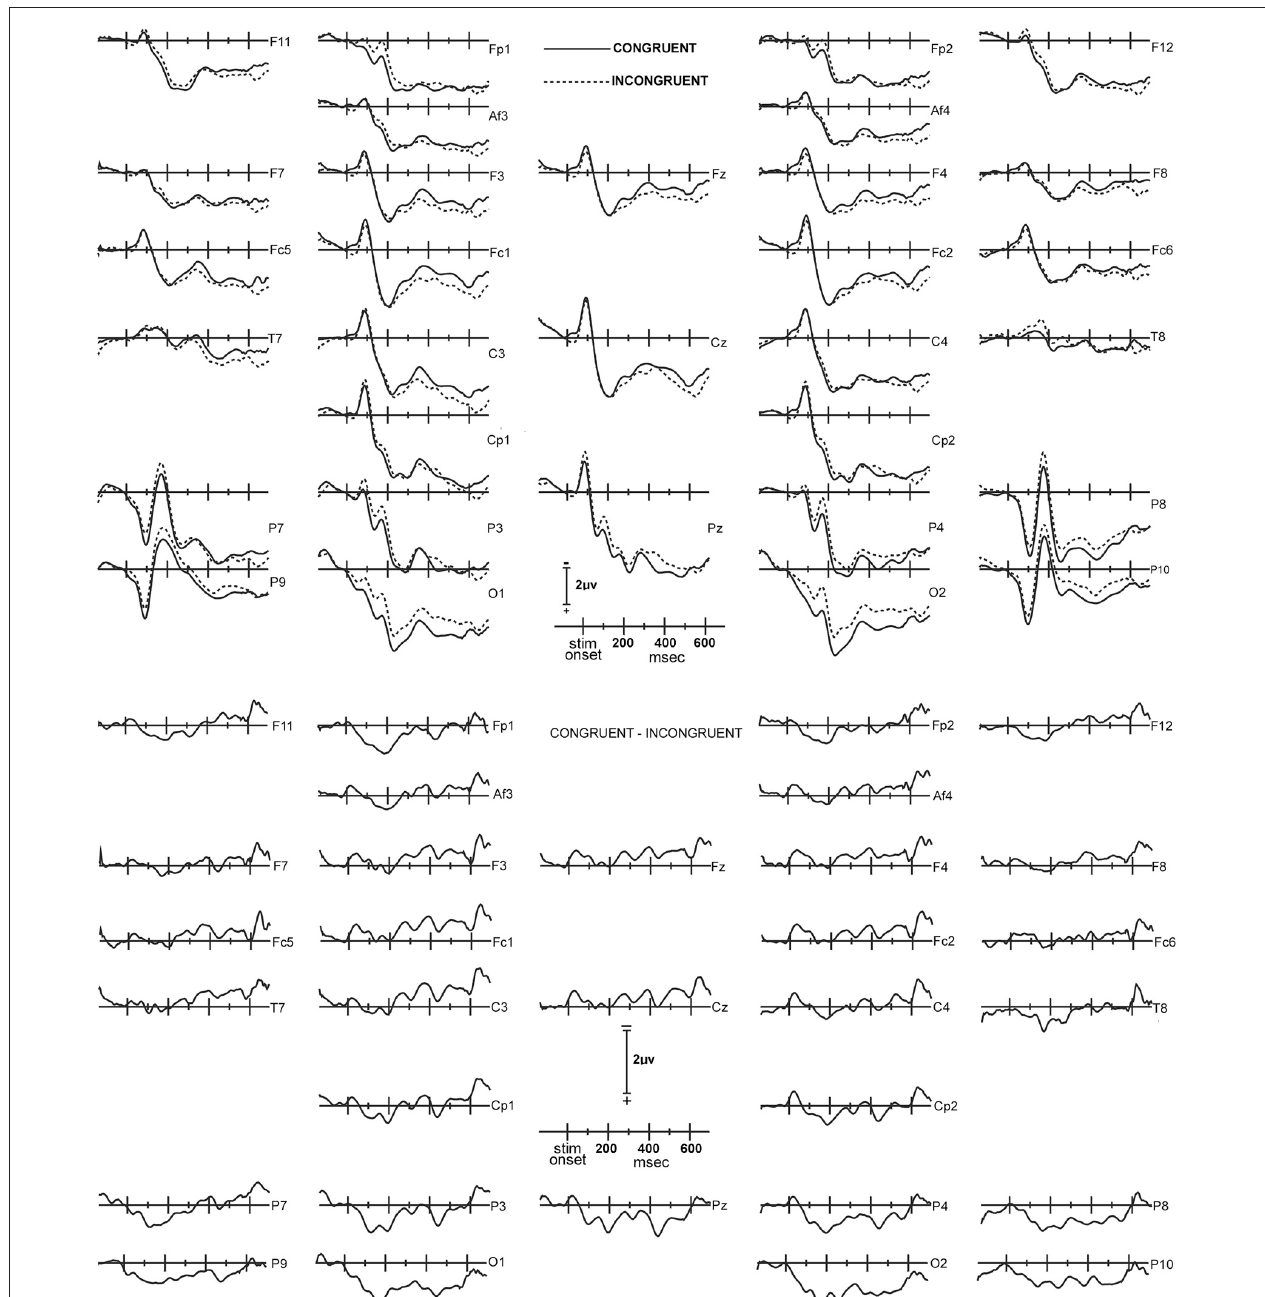
FIGURE 1 | Upper panel: Congruent (solid lines) and incongruent (dashed lines) ERP waves, averaged across all 14 subjects. The waveform layout is in approximate correspondence to the placement of the electrodes on the head. The top of the panel corresponds to the front of the head, and the right side of the panel corresponds to the right hemisphere. In this, the waveforms